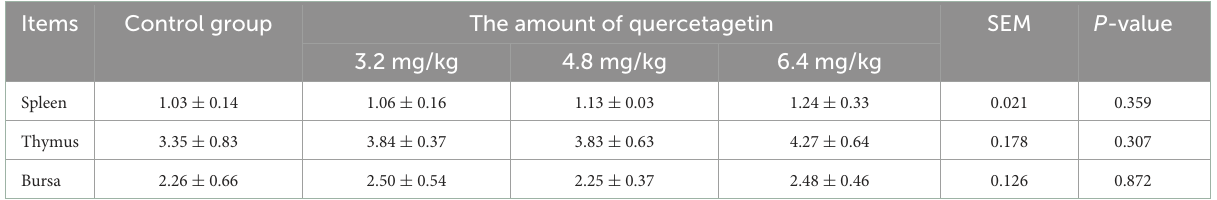
TABLE 5 Effect of quercetagetin on organ indices of broilers